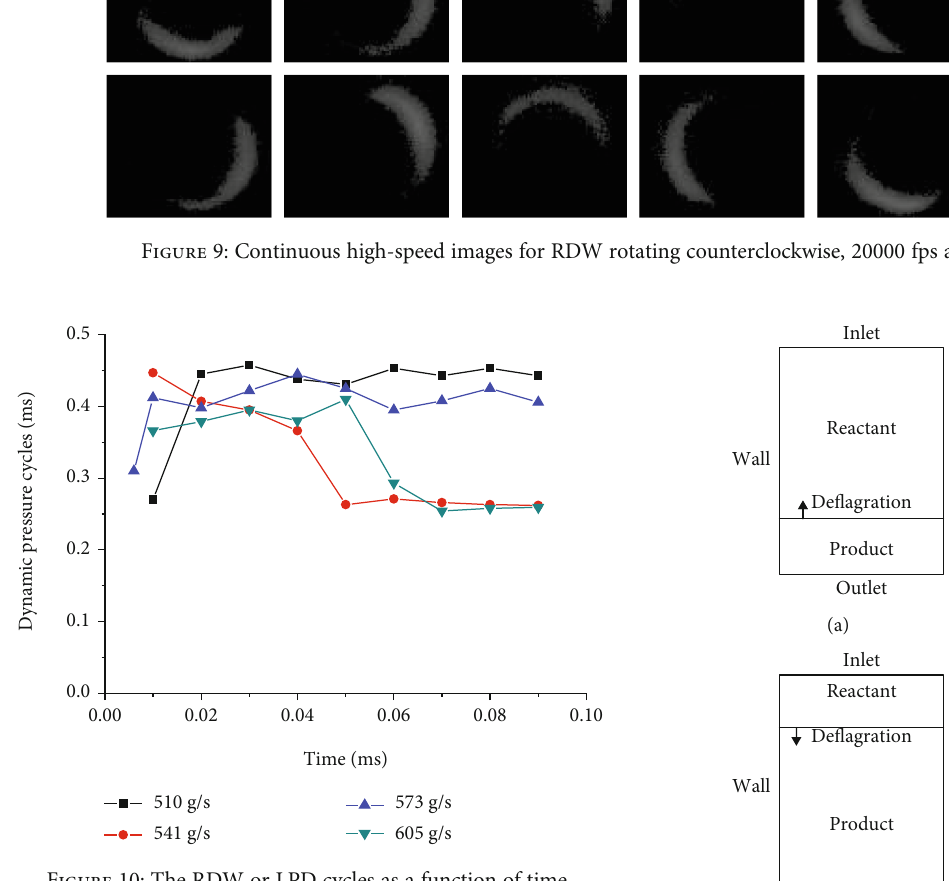
Figure 10: The RDW or LPD cycles as a function of time. Table 2: The RDW velocity for the critical equivalence ratio at di ff erent hydrogen mass fl ow rates. Figure